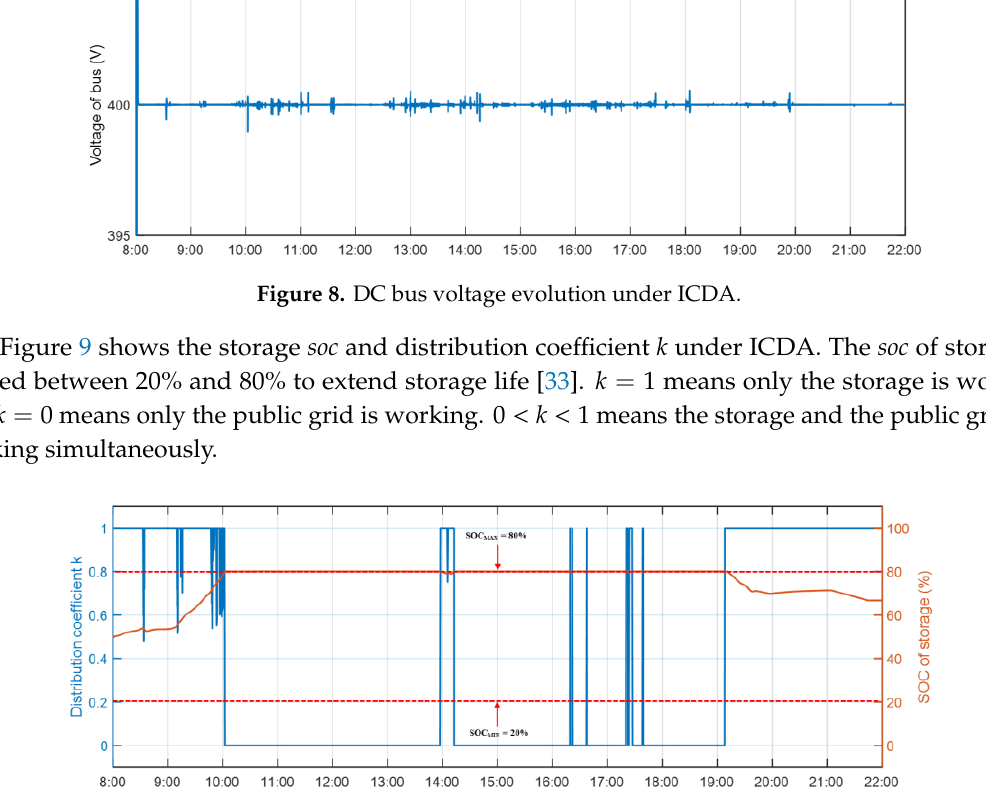
Figure 9. Storage soc and distribution coe ffi cient K under ICDA. Figure 9. Storage 𝑠𝑜𝑐 and distribution coefficient 𝐾 under ICDA. Figure 9. Storage 𝑠𝑜𝑐 and distribution coefficient 𝐾 under ICDA. Figure 9. Storage 𝑠𝑜𝑐 and distribution coefficient 𝐾 under ICDA.